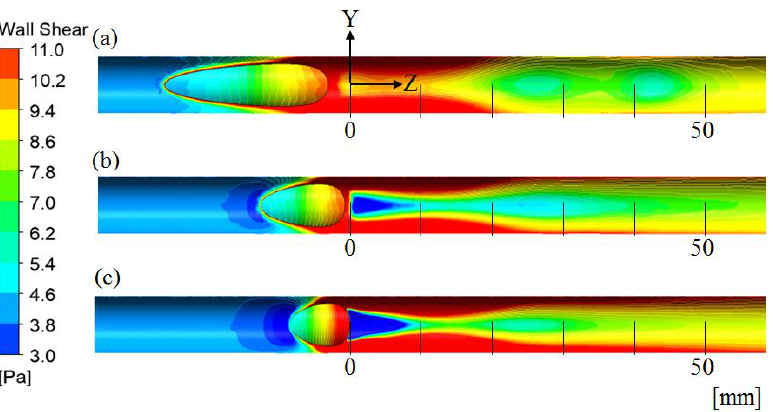
Figure 10. Wall shear stress contour of the upper surface, hematocrit is 58%, anastomosis angle of ( a ), ( b ), and ( c ) are 15°, 30°, and 45°, respectively.